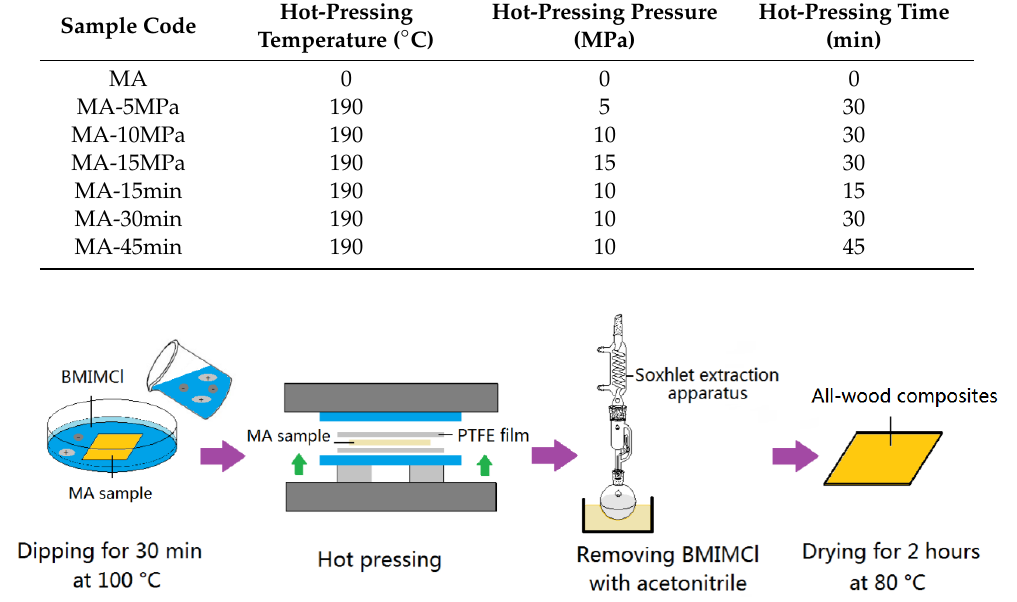
Table 1. Sample codes and their corresponding processing conditions.